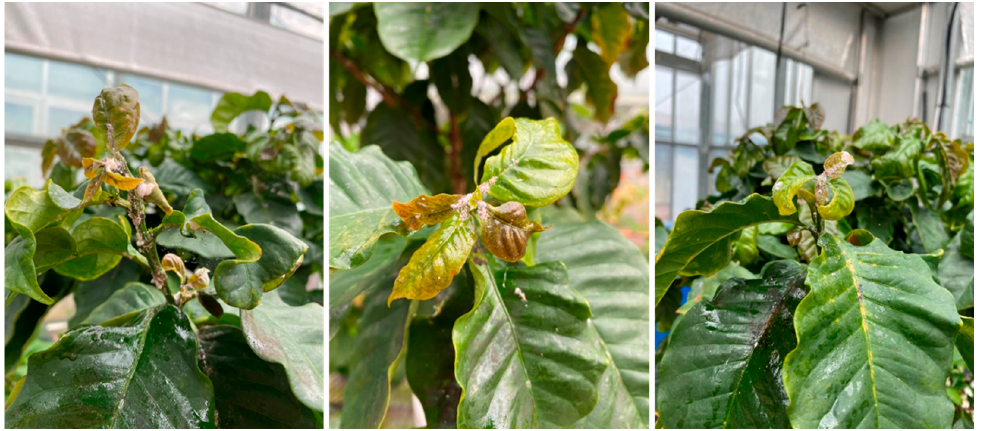
Figure 1. Disease and insects in the coffee plants grown indoors.